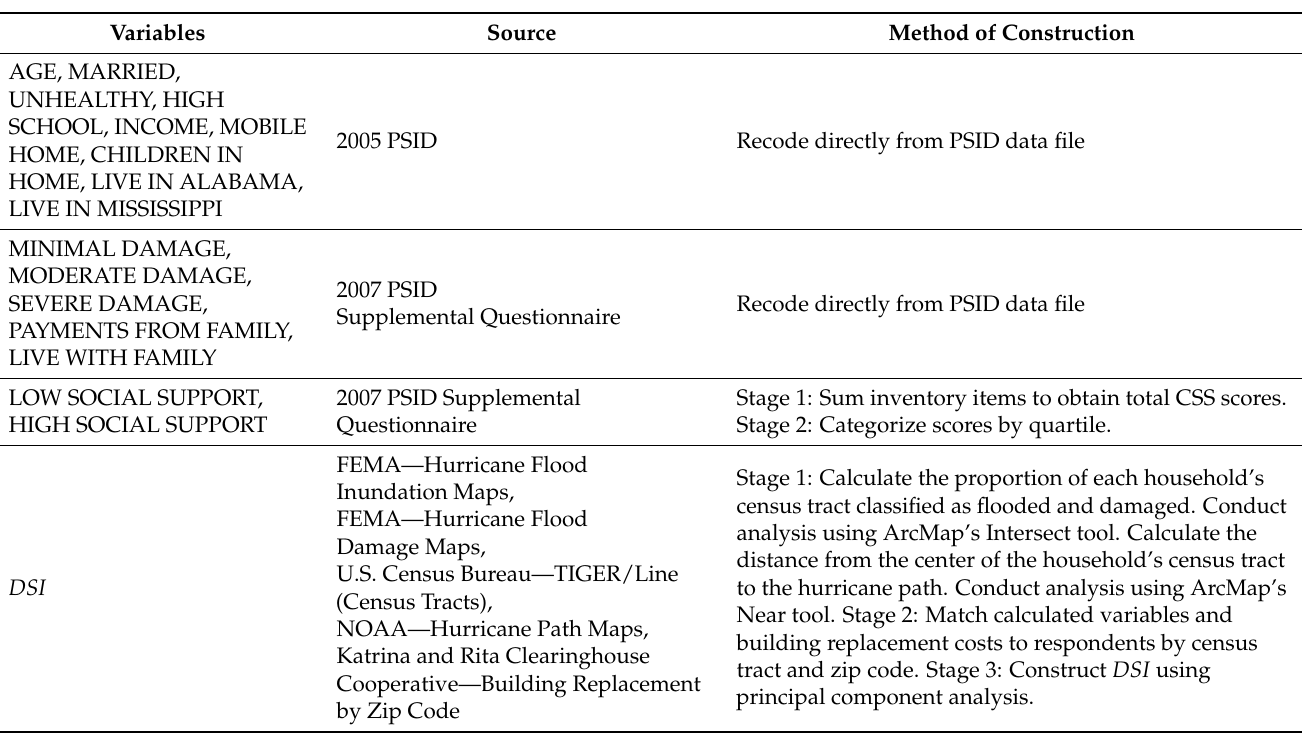
Table 1. Source and Method of Construction for Explanatory